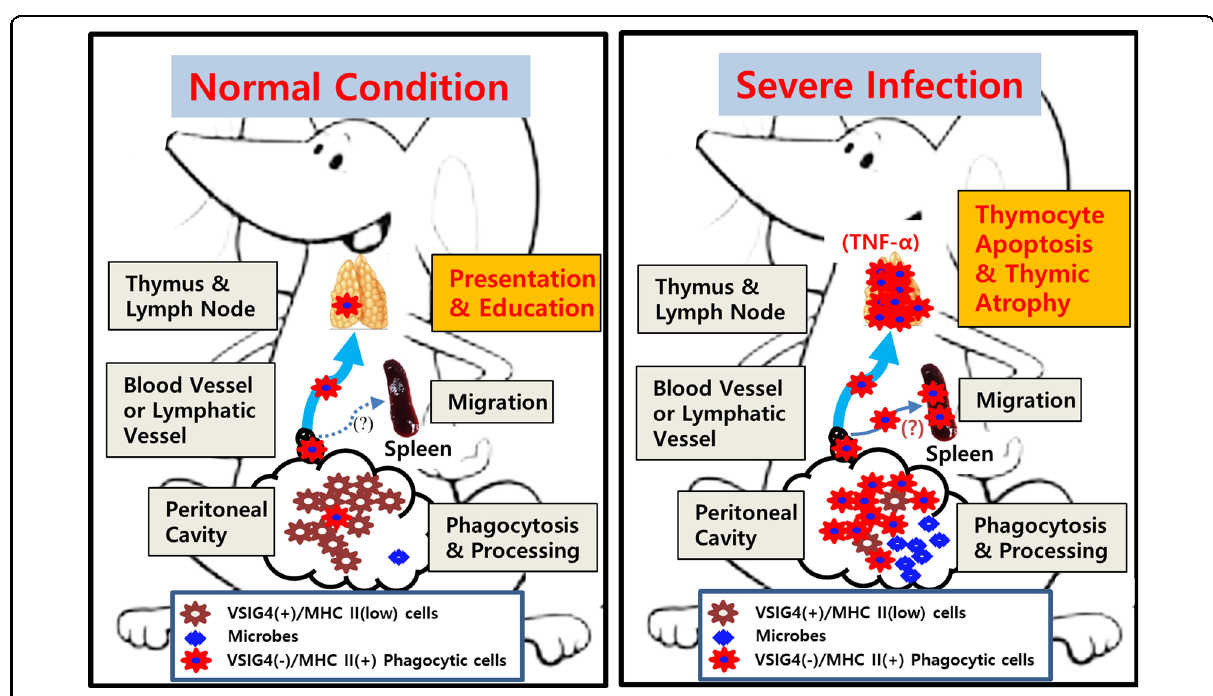
Fig. 8 Schematic representation of the proposed mechanism for thymic atrophy in CLP Mice. Left panel: In normal condition, small peritoneal V4( + )/MHC II(low) cells ingest a small number of invading microbes and become activated cells. These activated cells migrate to thymus through blood or lymphatic vessels, and may change to V4( − )/MHC II( + ) cells in process of migration. These activated V4( − )/MHC II( + ) cells may be involved in the role of antigen-presenting cells in thymus. Right panel: In severe infection, many peritoneal V4( + )/MHC II(low) cells ingest a large number of invading microbes and become over-activated cells. Many over-activated cells vigorously migrate to thymus through blood or lymphatic vessels, and may change to V4( − )/MHC II( + ) cells in process of migration. In thymus, “ TNF- α ” secreted by over-activated V4( − )/MHC II( + ) cells induces apoptosis of DP thymocytes resulting in thymic